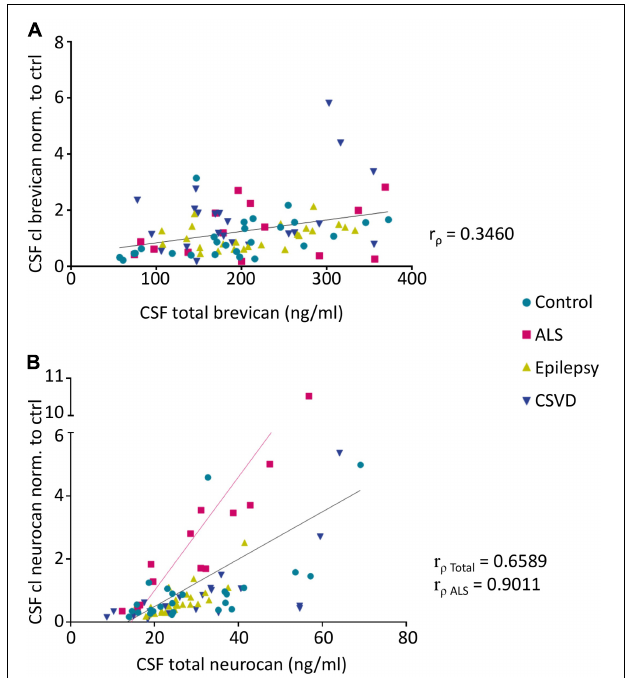
FIGURE 5 | Spearman’s correlation analysis reveals significant correlations between CSF levels of cleaved brevican (normalized to controls) and total brevican (r ρ = 0.346, p < 0.05) (A) (Pairs: Ctr. n = 26, ALS n = 14, Epi n = 24, CSVD n = 22) and also between the CSF levels of cleaved neurocan (normalized to controls) and total neurocan (r ρ = 0.6589, p < 0.001) (B) (Pairs: Ctr. n = 25, ALS n = 13, Epi n = 24, CSVD n = 20) over all groups. Within the ALS group this correlation is strongest (r ρ = 0.9011, p < 0.0001). CSF, cerebrospinal fluid, ALS, amyotrophic lateral sclerosis, CSVD, cerebral small vessel